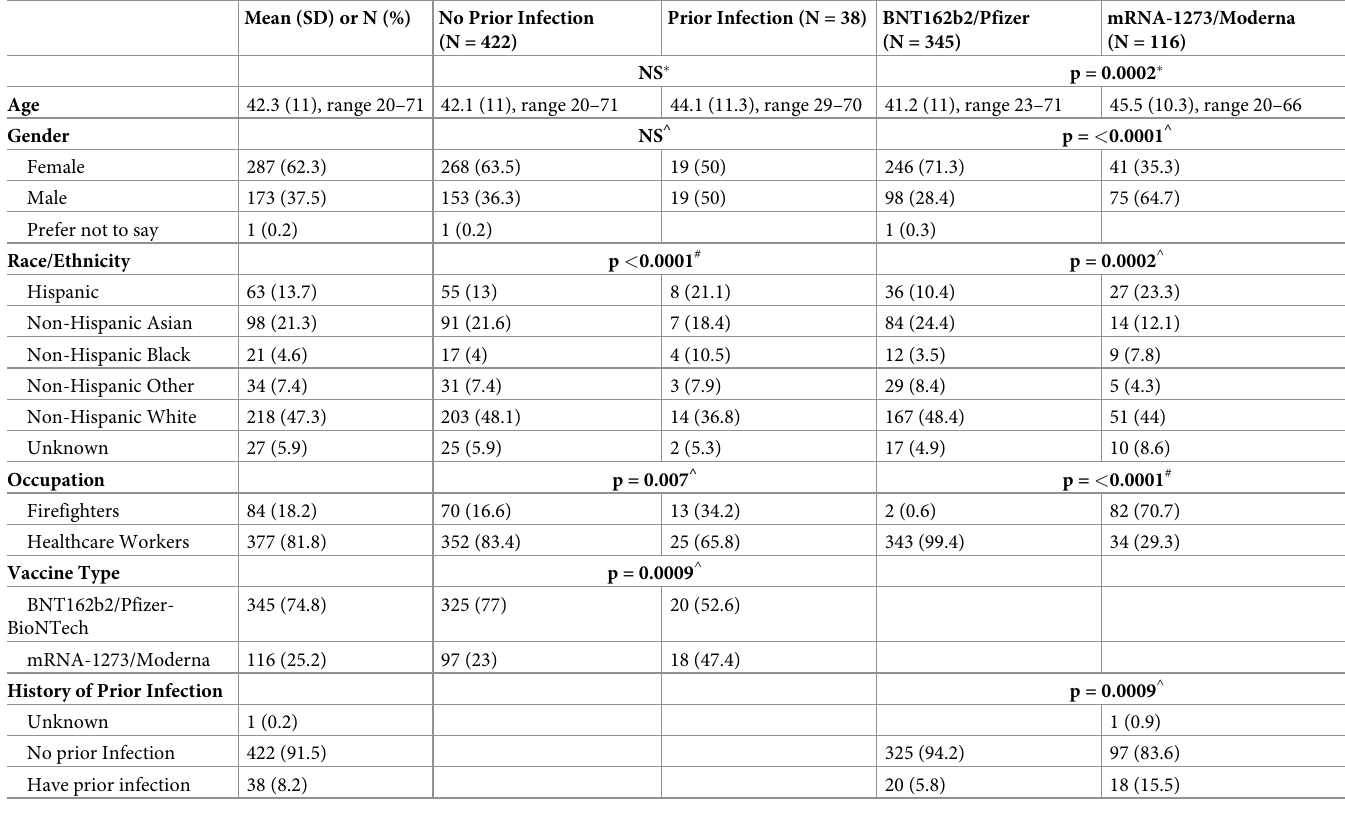
Table 1. Characteristics of the